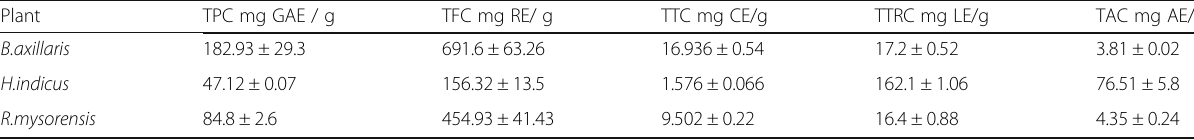
Table 5 Quantitative phytochemical analysis of the active fractions Plant